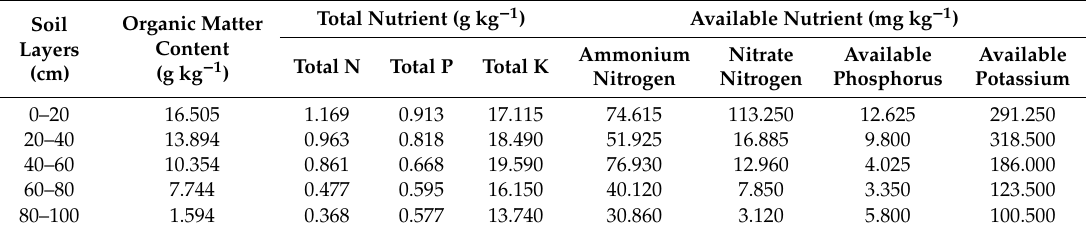
Table 2. Soil nutrient content in the experimental area.